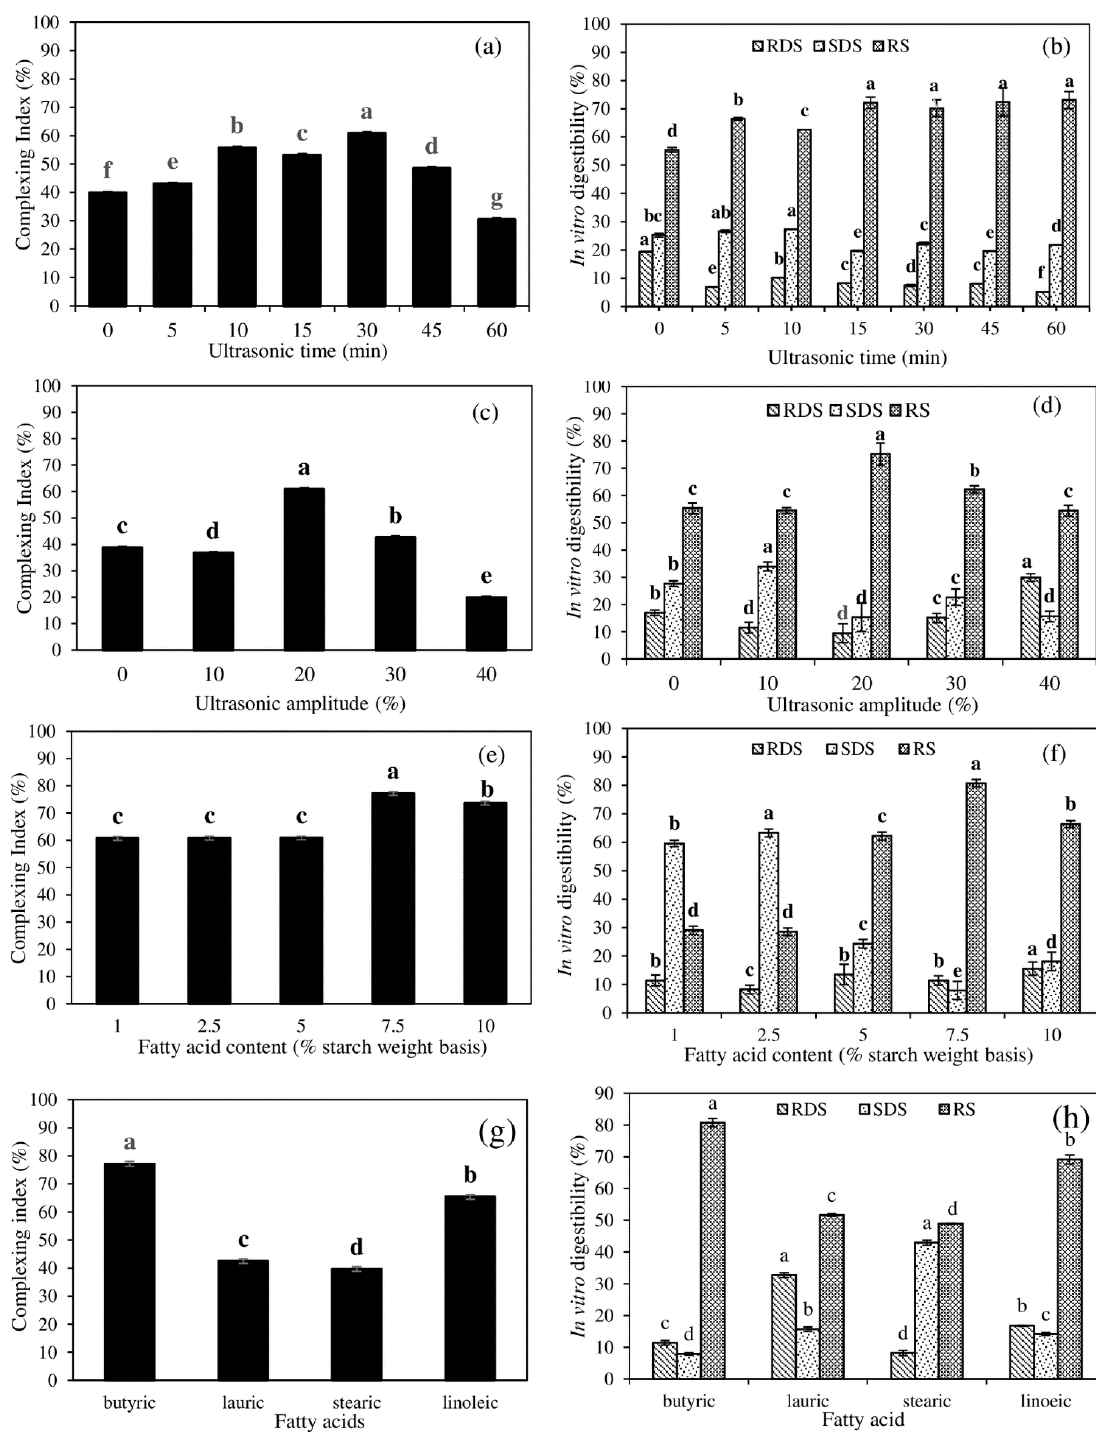
Figure 1. The effect of synthesized conditions on the complexing index ( a , c , e , g ) and in vitro digestibility ( b , d , f , h ) of the ultrasonically treated Noui Khuea (NK) starch – lipid complex. Effect of ultrasonic time ( a , b ); effect of ultrasonic amplitude ( c , d ); effect of fatty acid concentration ( e , f ); effect of fatty acid chain length ( g , h ). The reaction was conducted for 30 min to determine the impact of ultrasonic am- plitude, fatty acid concentration, and fatty acid chain length. Bars represent the standard deviations from triplicate determinations. Different letters under the same parameter indicate the significant differences ( p < 0.05). RDS, SDS, and RS were analyzed separately. RDS = rapidly digestible starch; SDS = slowly digestible starch; RS = resistant